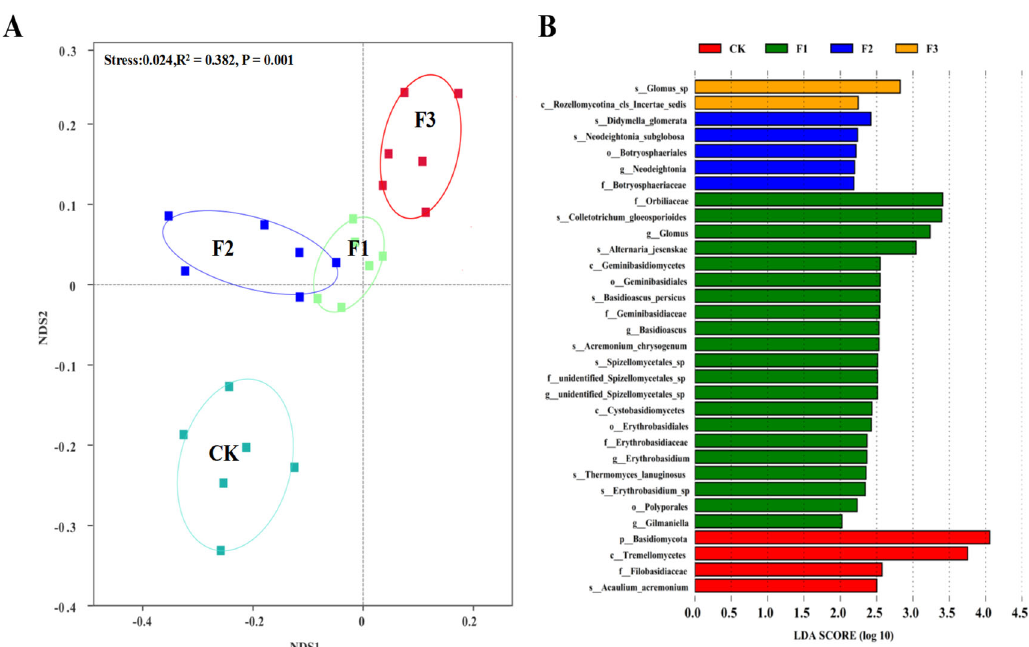
Figure 7. Non-metric multidimensional scale (NMDS) ranking of the rhizosphere fungal community composition of Chinese yam under different foliar fertilizer ( A ) and indicator fungi with an LDA score of 2 or higher for fungal species under different foliar fertilizer ( B ). LDA Effect Size (LEfSe) algorithm was used on OTUs level to determine taxa that differentially represented between different treatments. CK, spray with water; F1, NPK foliar fertilizer; F2, NPK+Fe-Mn-Zn foliar fertilizer; F3, Fe-Mn-Zn foliar fertilizer.